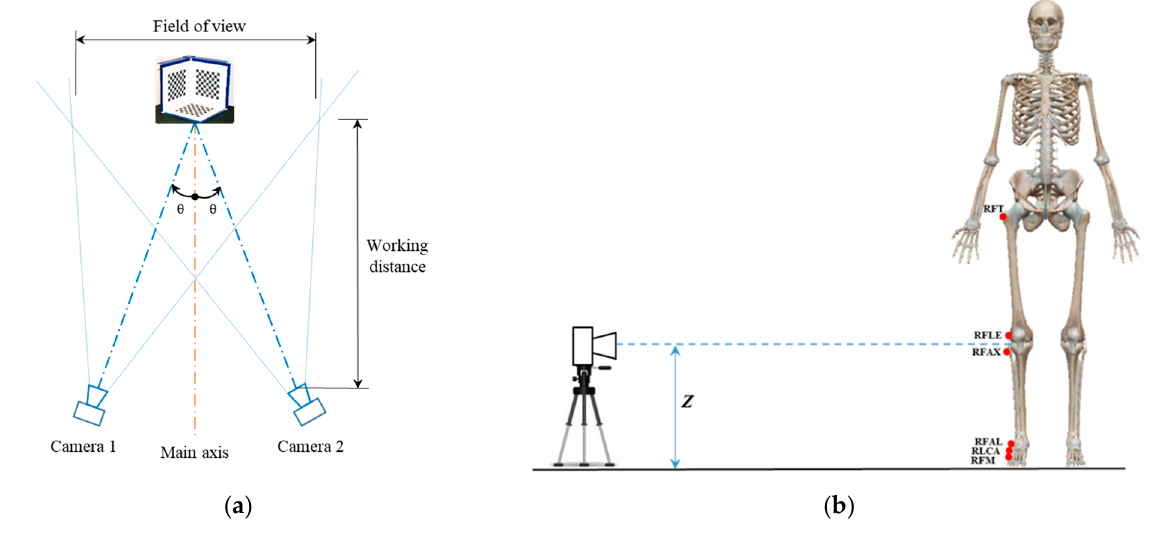
Figure 5. Experimental set up: ( a ) scheme of distribution, and ( b ) camera location at knee height.